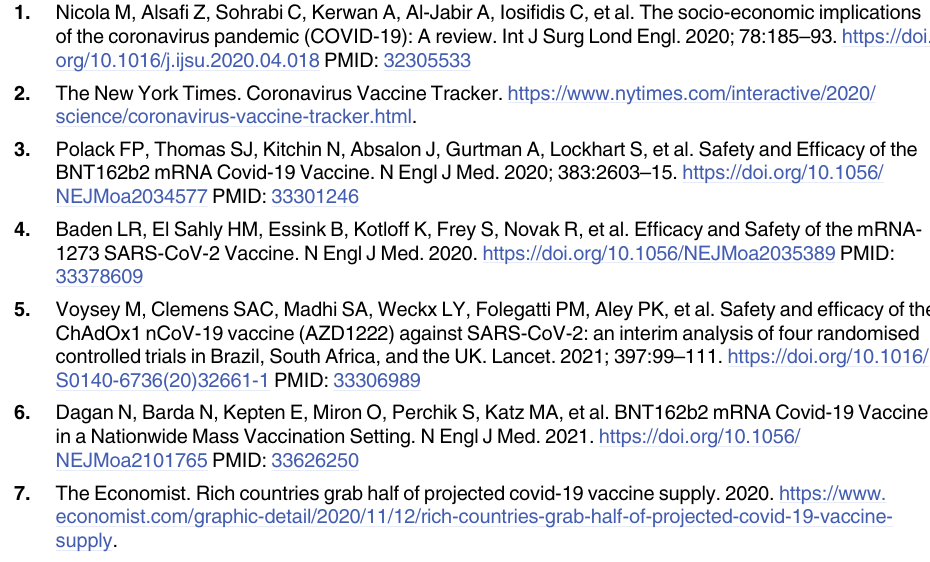
S10 Data. The individual numerical values for the following figure panels: Fig ED, EE, and EF. (XLSX) S11 Data. The individual numerical values for the following figure panels: Fig FA, FB, and FC. (XLSX) S12 Data. The individual numerical values for the following figure panels: Fig FD, FE, and FF. (XLSX) S1 Text. Supporting